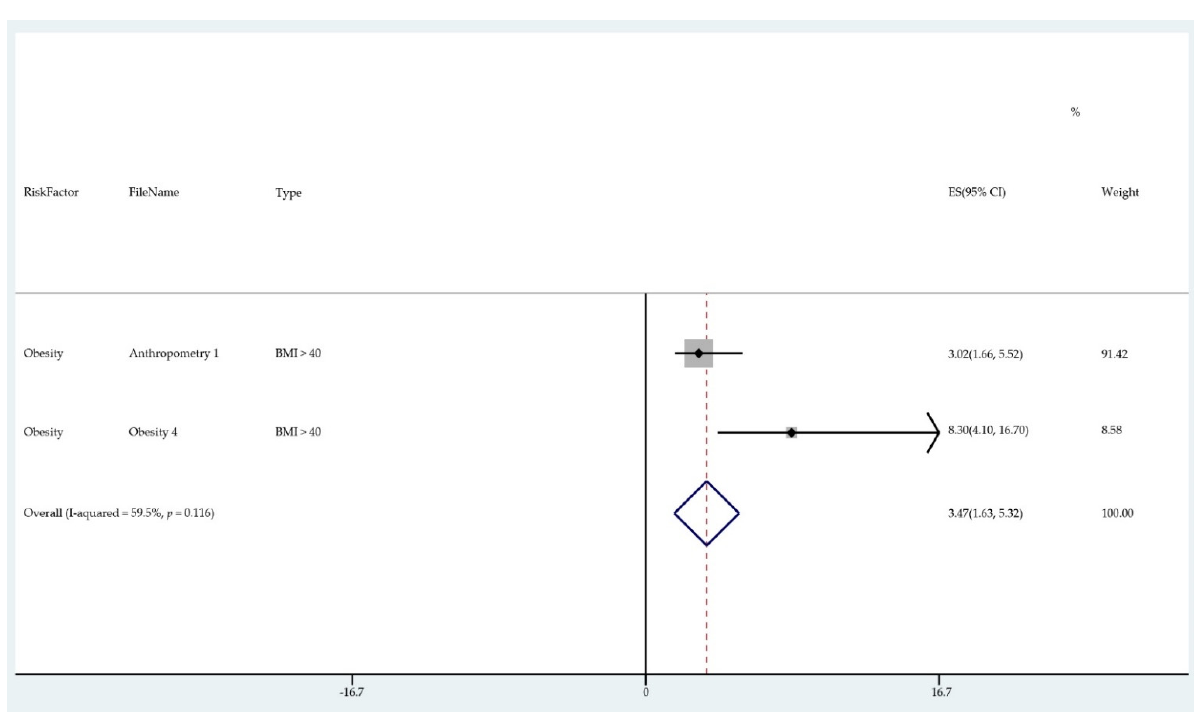
Figure 2. Forest plot to show risk of BMI > 30.